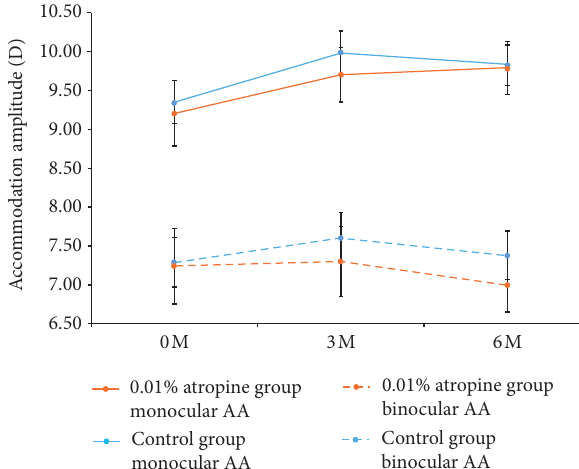
Figure 2: Mean and SE of AA in the atropine and control groups at baseline and follow-up visits. There was no significant difference in monocular and binocular AA between the two groups at two follow-up visits. SE � standard error; AA � accommodation am- plitude; D � diopter.